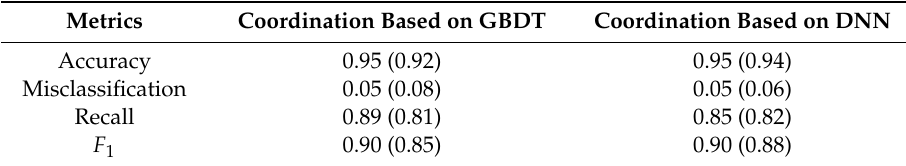
Table 4. The comparison of the results between the coordination model and